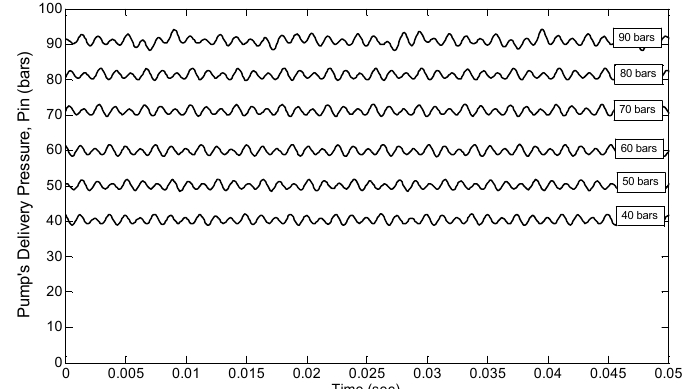
Figure 5. Pressure measurement for different pressure settings for use as inlet pressure.